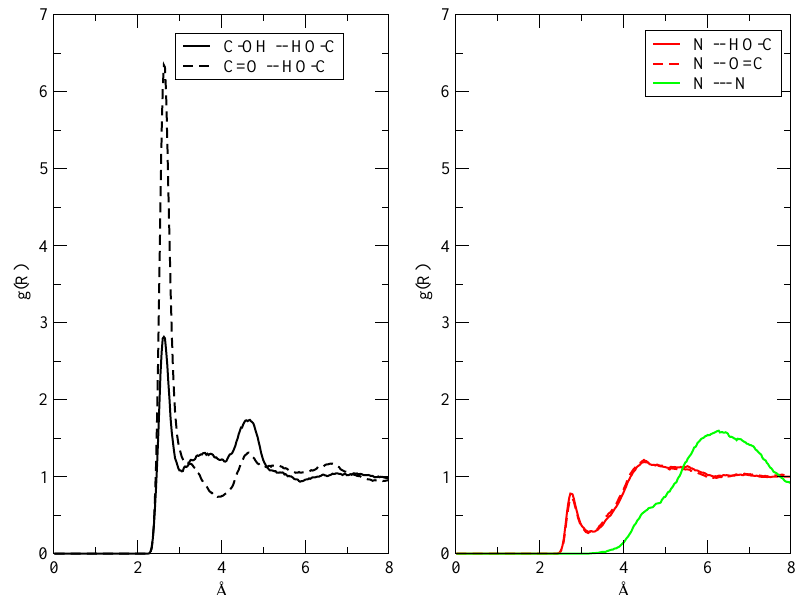
Figure 4. Interatomic g(r) for the H-bonds in AcOH (left, black lines) and for AcOH–TEA interactions (right, red lines). In green, on the right, I have reported the N–N interactions between TEA molecules.